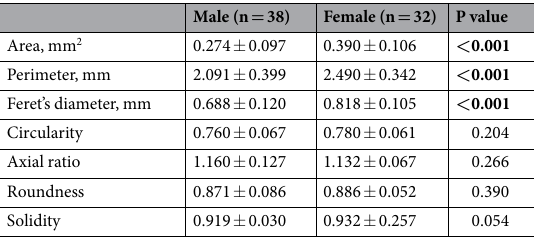
Table 3. Difference of sex on the each